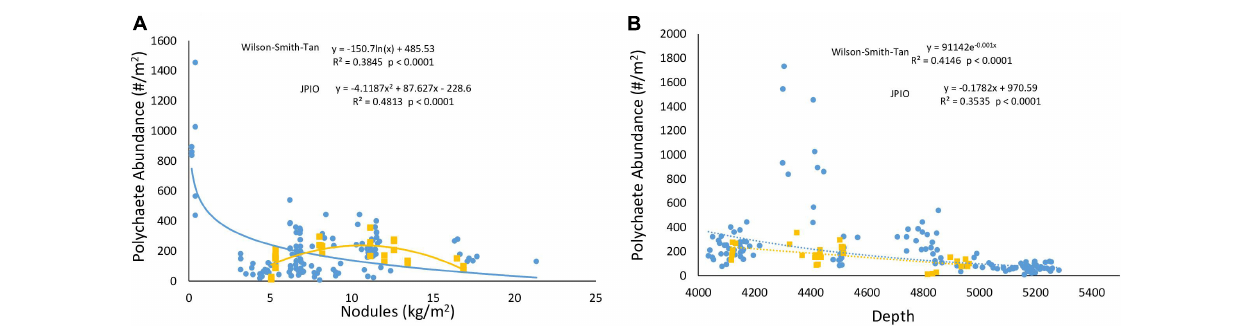
Frontiers in Marine Science |